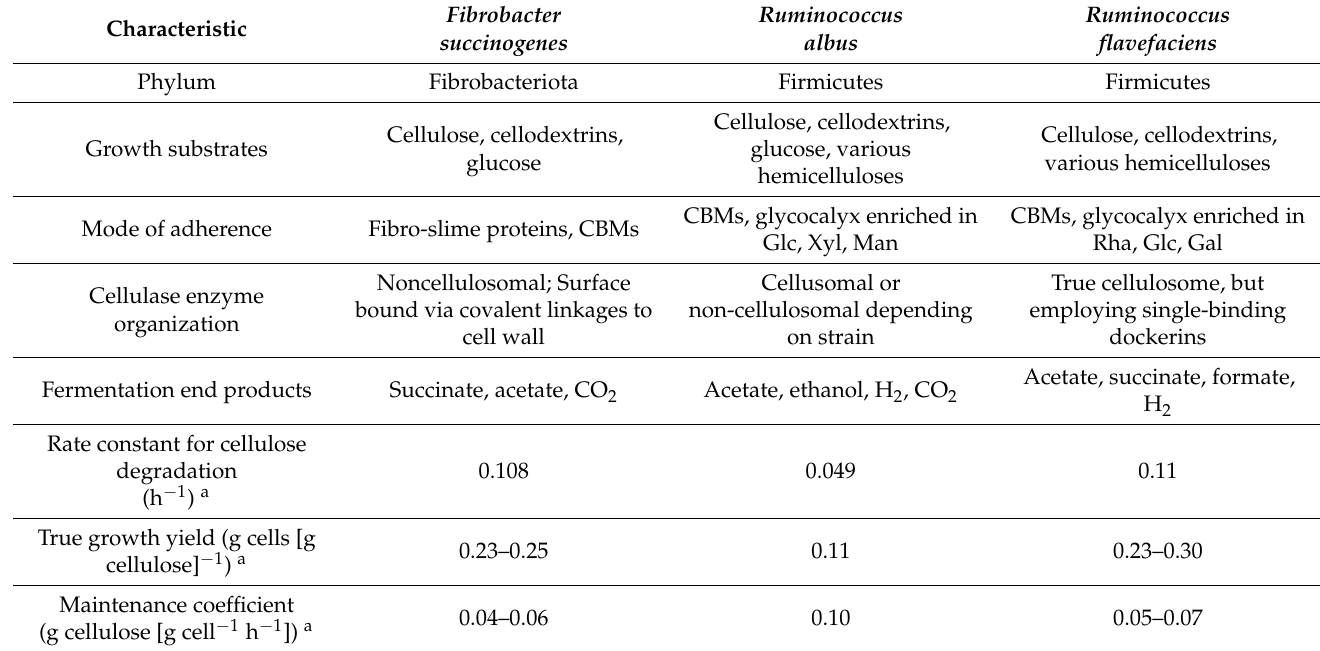
Table 2. Major differences among the three predominant ruminal cellulolytic bacteria, revealed from studies in pure culture.